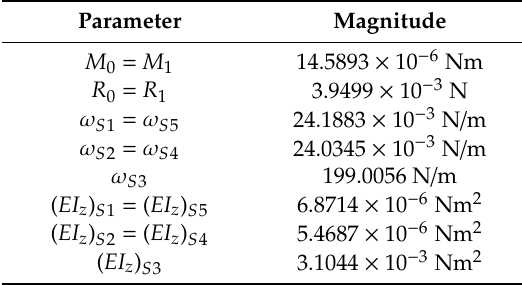
Table 2. Values for the bending moments, support reactions, weight per unit length and bending sti ff ness for each section of the piezoelectric nanogenerator.